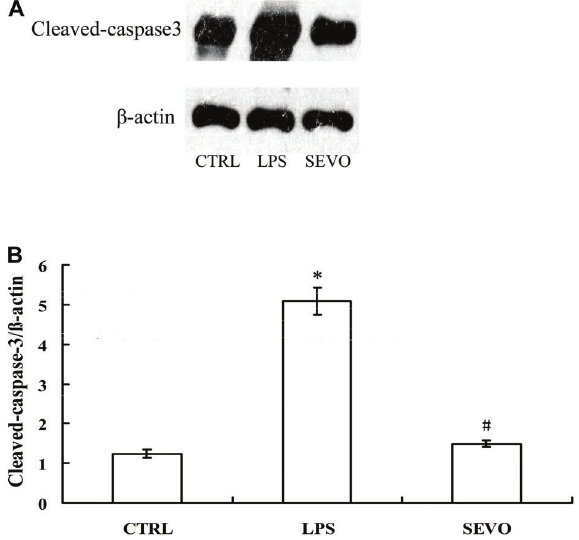
Figure 6. A , Western blotting for cleaved-caspase-3 in the lung tissues. B , Relative levels of cleaved-caspase-3. CTRL: control group injected intratracheally with normal saline; LPS: injected intratracheally with lipopolysaccharide; SEVO: injected with LPS plus inhaled sevo fl urane for 30 min. Data are reported as means ± SD (n=6 per group). *P o 0.01 vs CTRL; # P o 0.01 vs LPS